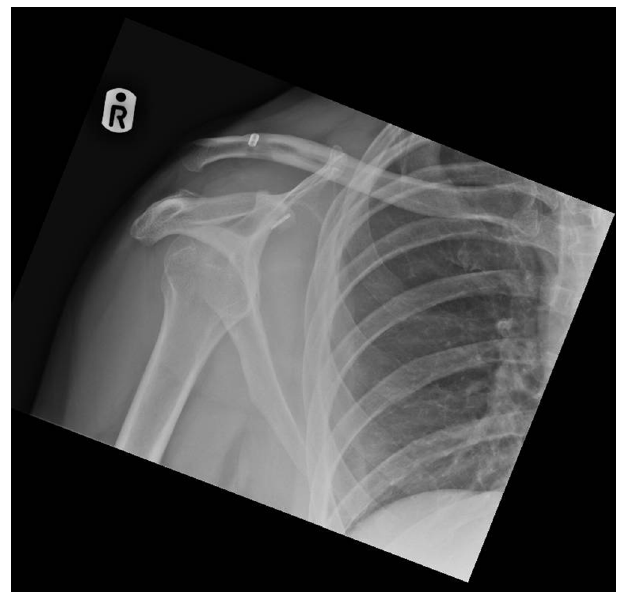
Figure 2. Example of medial mal-positioning of the coracoid tunnel, leading to loss of CC reduction and post-operative sublux- ation of the coracoid endobutton.